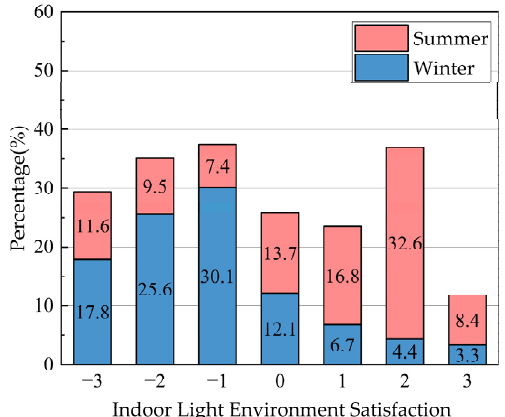
Figure 7. Human subjective comfort evaluation—indoor thermal